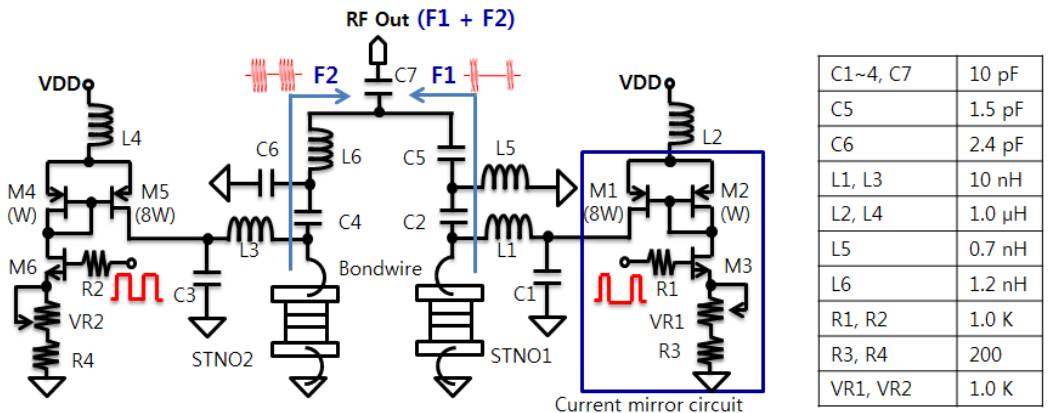
Figure 6. The schematics of the biasing an STNO and modulating a data through the current mirror circuit including the T-junction matching circuit on the two STNOs of the array structure.